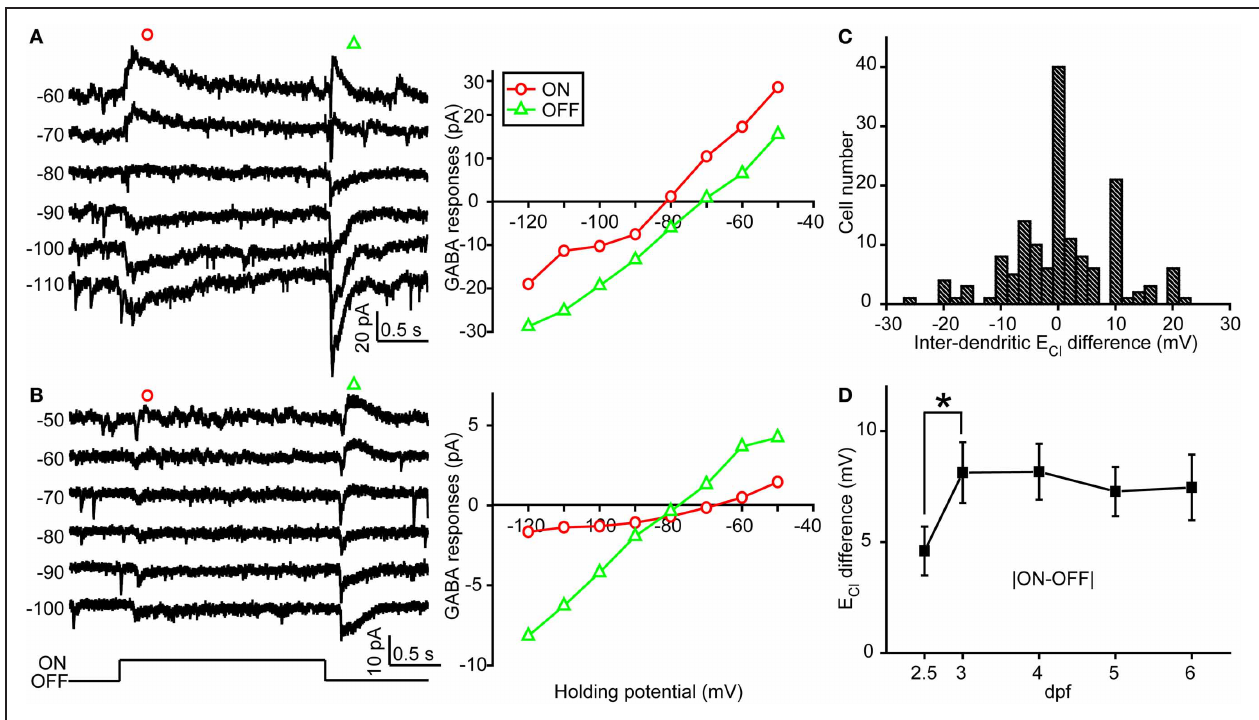
FIGURE 3 | Inter-dendritic E Cl difference between ON and OFF dendrites of zebrafish ON-OFF RGCs. (A,B) Left, light-evoked ON and OFF synaptic responses recorded at different holding potentials from two ON-OFF RGCs under gramicidin-perforated patch recording mode. Right, I–V curves of the late-phase components of light-evoked ON (red circle)